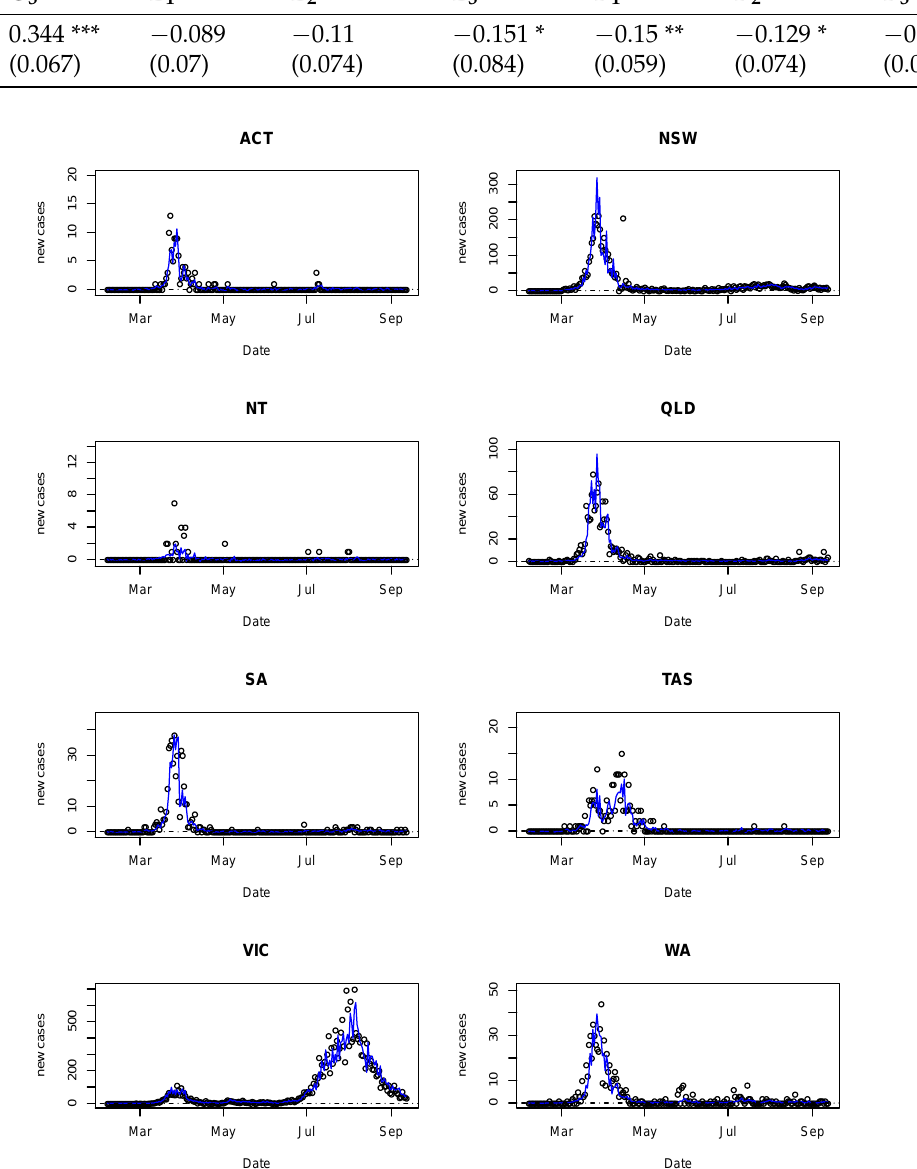
Figure 5. Observed (circle) and predicted (solid line) number of daily new cases in all states and territories. All the numbers have been transformed back to the original